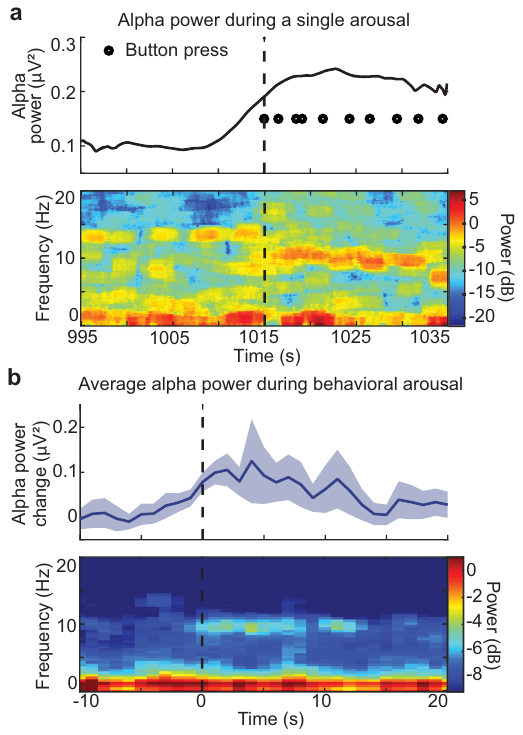
Fig. 1 | Behavioral arousals are linked to a transition in cortical EEG. a An examplebehavioralarousal(dashedline)isaccompaniedbyanincreaseinoccipital alpha power (8 – 13Hz). Top: the alpha power increase coincides with the return of behavior. Power is temporally smoothed in 2 s sliding windows. Bottom: the spectrogramdemonstratesareturnofoccipitalalphadirectlyfollowingbehavioral arousal. b Top: the mean alpha power signi fi cantly increases atbehavioral arousal, consistent with a transition to the awake state (6 subjects, 66 arousals). Power is temporally smoothed in 2 s sliding windows. Shading is a standard error. Bottom: average spectrogram shows a speci fi c increase in alpha power during behavioral arousal. Source data are provided in “ Fig. 1 Source Data ” fi